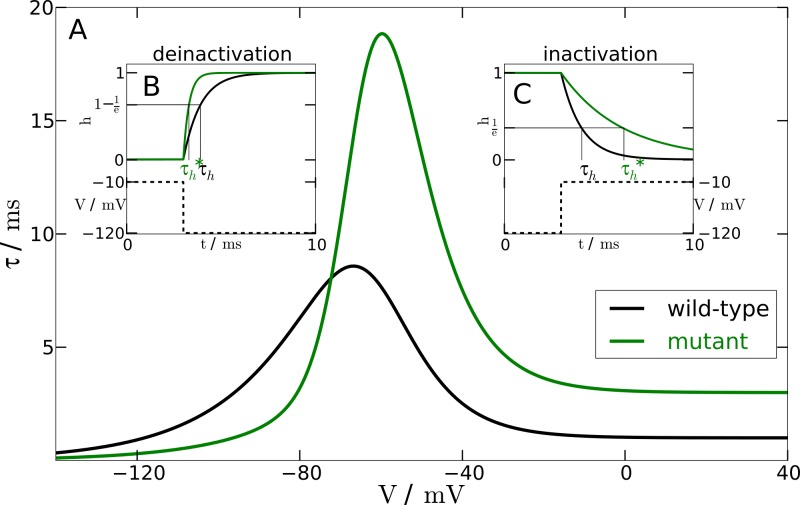
Inactivation time constant as a function of membrane potential.(A) Voltage-dependent time constant for mutation \documentclass[12pt]{minimal}
\usepackage{amsmath}
\usepackage{wasysym}
\usepackage{amsfonts}
\usepackage{amssymb}
\usepackage{amsbsy}
\usepackage{upgreek}
\usepackage{mathrsfs}
\setlength{\oddsidemargin}{-69pt}
\begin{document}
}{}$({\tau }_{h}^{\ast })$\end{document}τh* and wild-type (τh). Insets show the response of h to a voltage-clamp protocol. (B) shows the deinactivation (i.e., recovery from inactivation) process as a response to a step in voltage from −10 mV to −120 mV. (C) shows the inactivation process by stepping the voltage from −120 mV to −10 mV. The intersections of the h-curve with the 1/e- and (1−1/e)-lines, respectively, show the actual time constants. For deinactivation \documentclass[12pt]{minimal}
\usepackage{amsmath}
\usepackage{wasysym}
\usepackage{amsfonts}
\usepackage{amssymb}
\usepackage{amsbsy}
\usepackage{upgreek}
\usepackage{mathrsfs}
\setlength{\oddsidemargin}{-69pt}
\begin{document}
}{}${\tau }_{h}^{\ast }$\end{document}τh* is three-fold smaller than τh. For inactivation \documentclass[12pt]{minimal}
\usepackage{amsmath}
\usepackage{wasysym}
\usepackage{amsfonts}
\usepackage{amssymb}
\usepackage{amsbsy}
\usepackage{upgreek}
\usepackage{mathrsfs}
\setlength{\oddsidemargin}{-69pt}
\begin{document}
}{}${\tau }_{h}^{\ast }$\end{document}τh* is three-fold lager than τh.